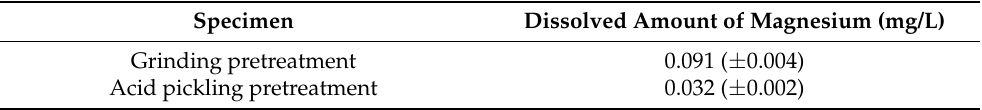
Figure 12. TEM image showing the cross-sectional morphology of LZ91 Mg alloy after acid pickling pretreatment for 30 s. Table 4. Dissolved amount of magnesium with different pretreatment in the conversion coating solution.